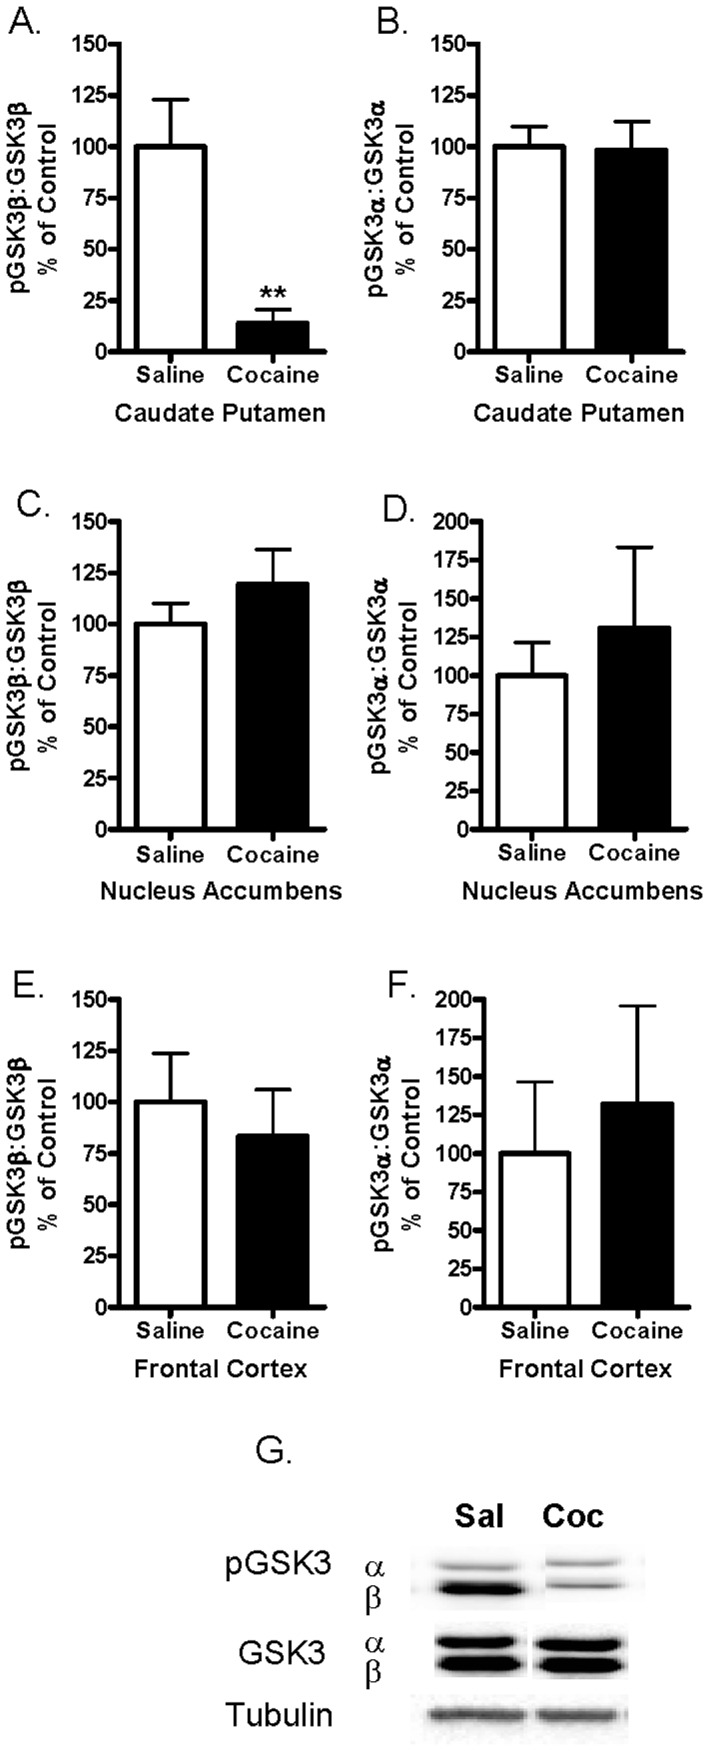
Phosphorylation of GSK3β but not GSK3α was reduced in the caudate putamen following acute administration of cocaine.(2A&B) Cocaine (20 mg/kg) reduced the phosphorylation of GSK3β but not GSK3α in the caudate putamen as compared to saline (**p<0.01). (2C&D) Levels of phosphorylated GSK3α/β were unchanged in the nucleus accumbens (core and shell combined) and (2E&F) frontal cortex 30 minutes following a cocaine injection. Bars represent the mean ± SEM (N = 6–9/group) and are expressed as a ratio of pGSK3α/β:total GSK3α/β. Data were analyzed by unpaired two-tailed Student t-tests. (2G) Representative immunoblots of caudate putamen tissue from saline (sal) and cocaine (coc) treated mice. Bands represent pGSK3α/β, total GSK3α/β and tubulin (from top to bottom).